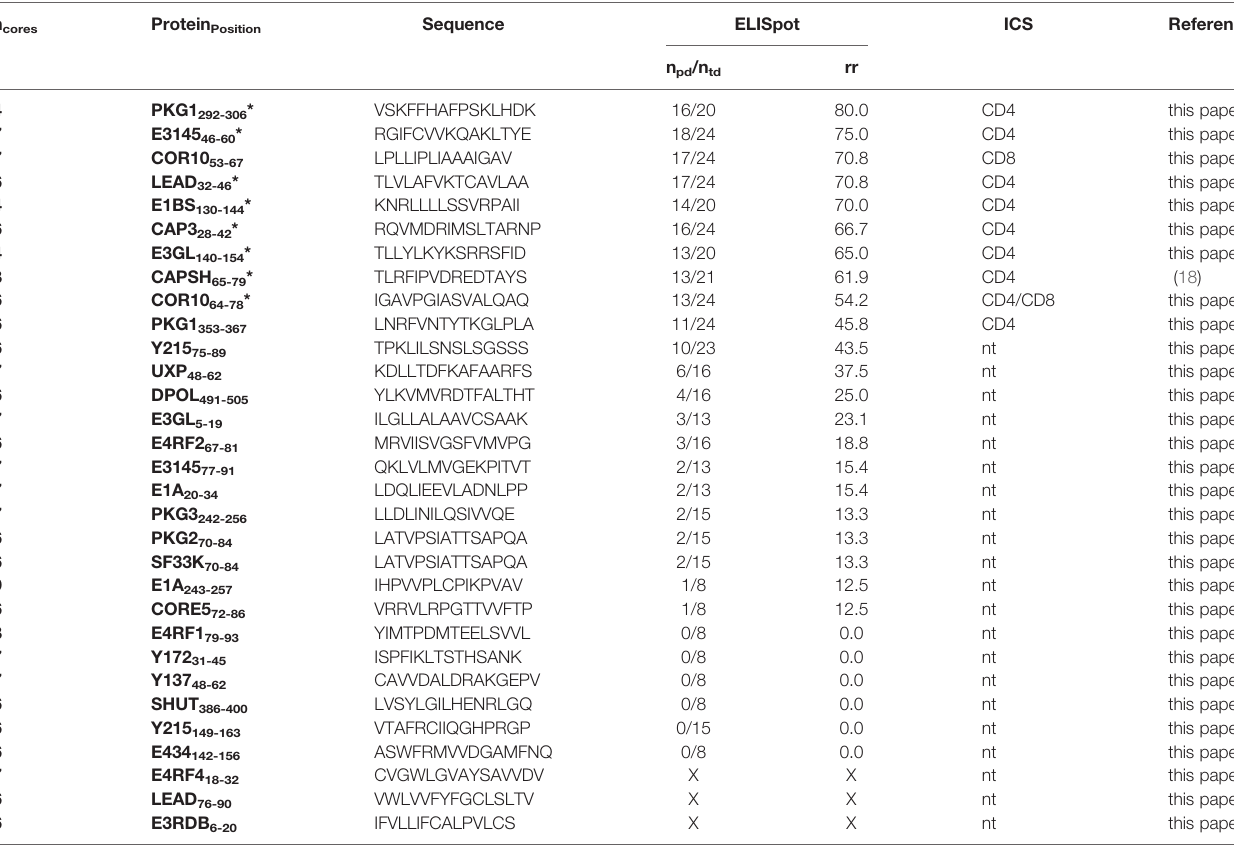
TABLE 1 | ELISpot and ICS results of HAdV epitope candidates. n